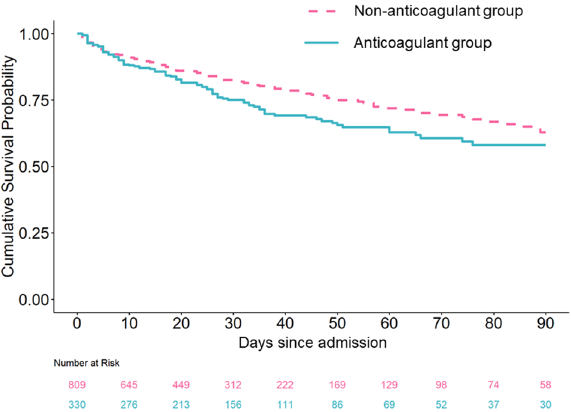
Figure 2. The Kaplan–Meier curves during the first 90 days for the cumulative survival of patients with and without anticoagulant therapy. The blue line represents the anticoagulant group and the dotted red line represents the non-anticoagulant group. Anticoagulant therapy was defined as the administration of antithrombin, recombinant human thrombomodulin, or their combination in the present study.